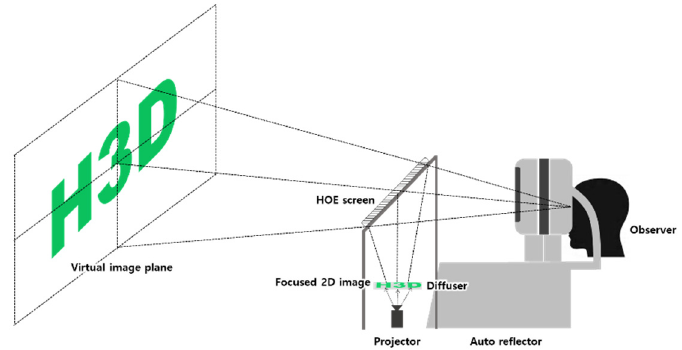
Figure 6. Measurement system using autorefractor for floating hologram system with a HOE.